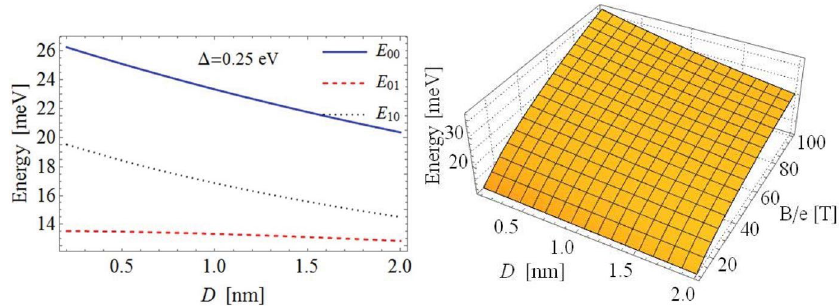
n of indirect PMEs on the separation D between gapped ˜ n , m on the separation D between gapped ˜ ˜